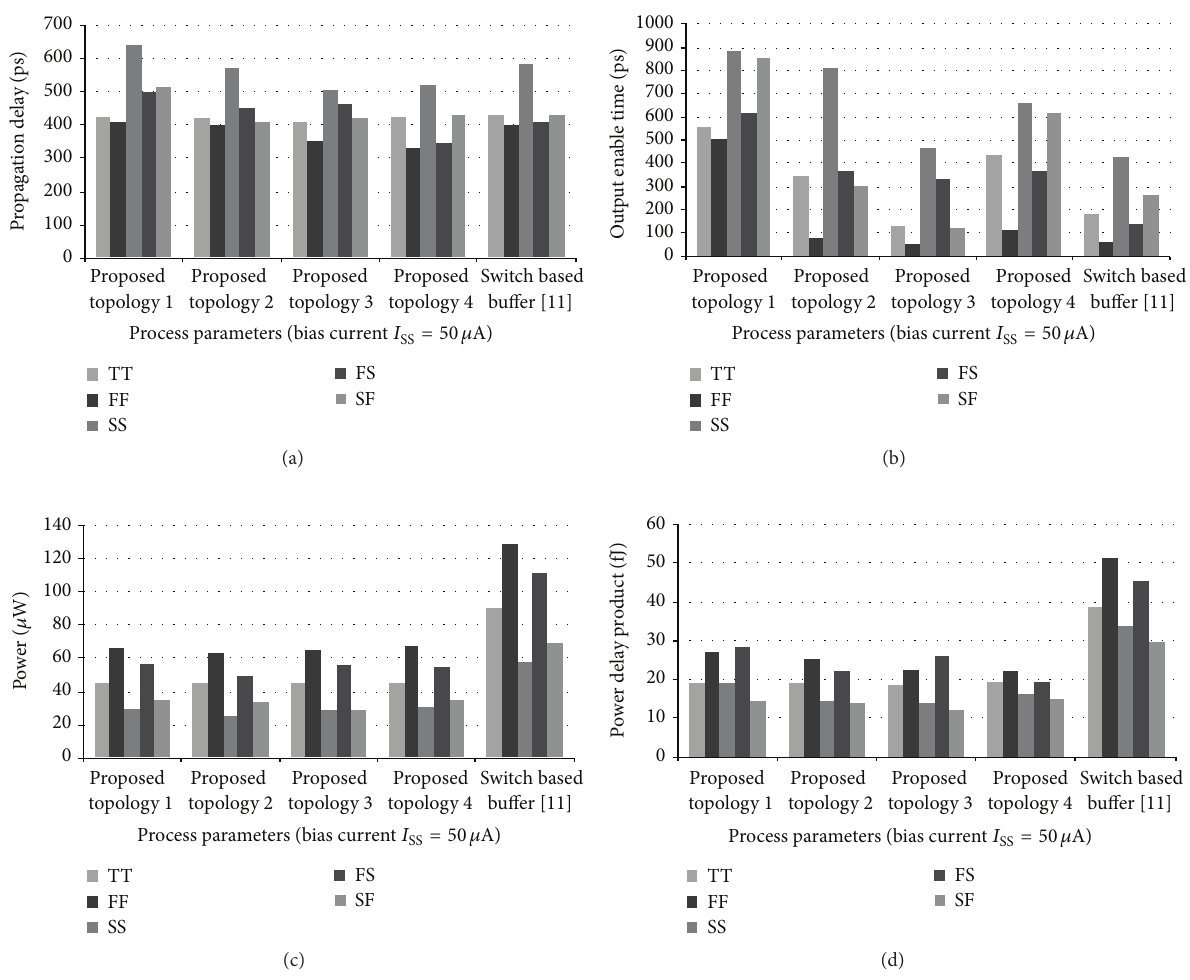
Figure 6: Impact of parameter variations on (a) propagation delay, (b) output enable time, (c) power, and (d) power delay product at different design